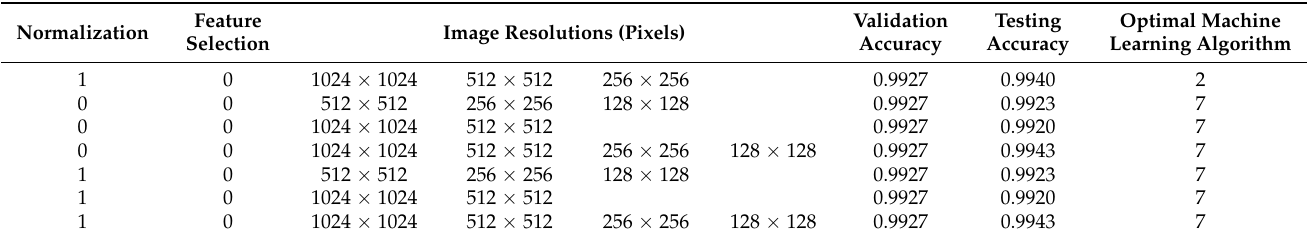
Table 3. Validation and testing three-category accuracies of the optimal CAD with texture analysis in the public dataset. Note: The optimal CAD was selected based on the validation accuracies of Table S4.